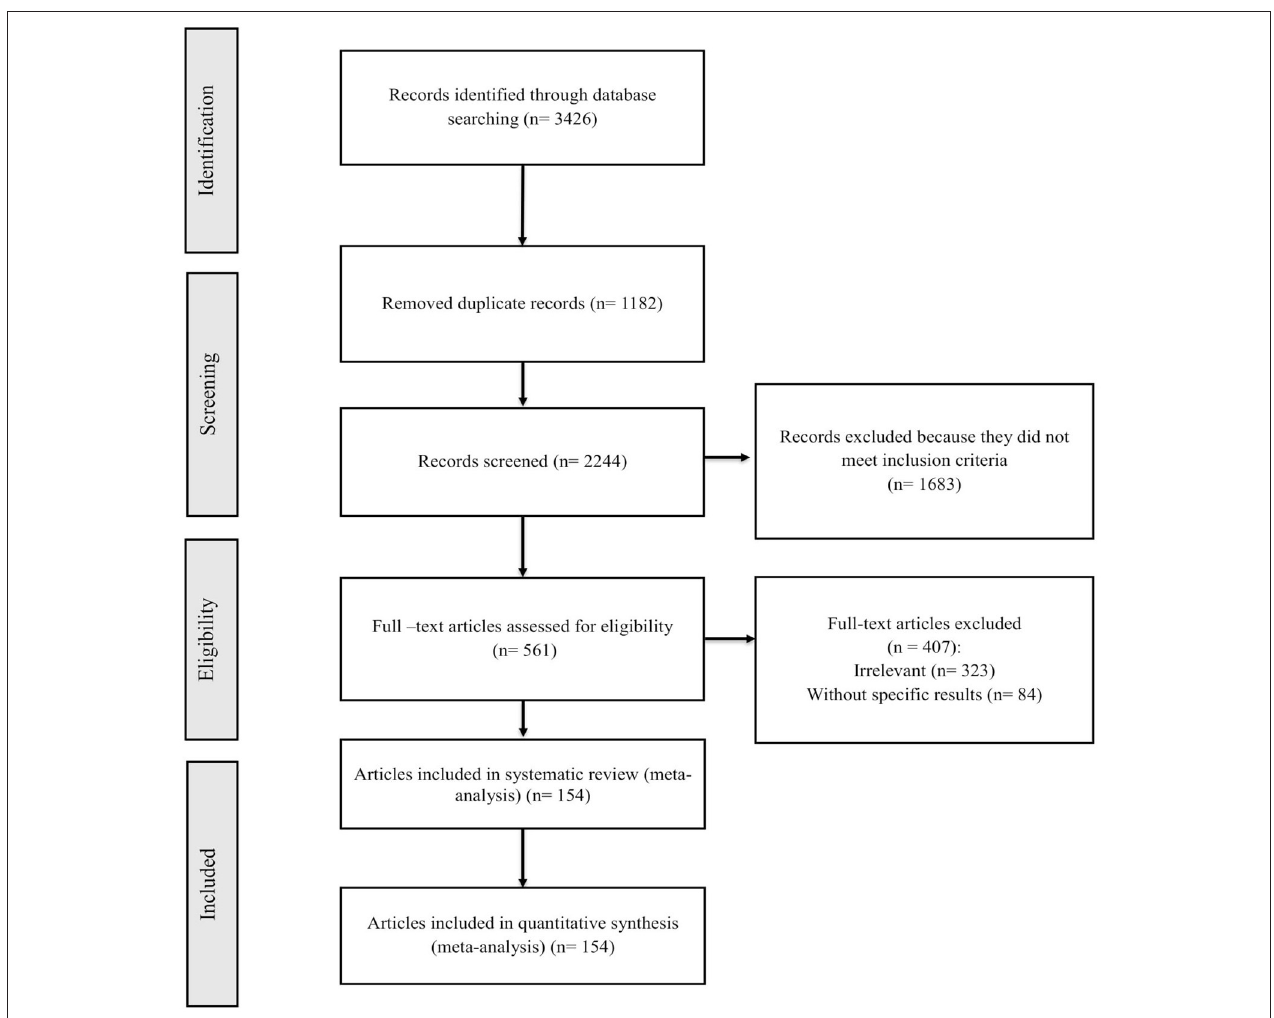
FIGURE 1 | PRISMA flow diagram describing summaries of included/excluded